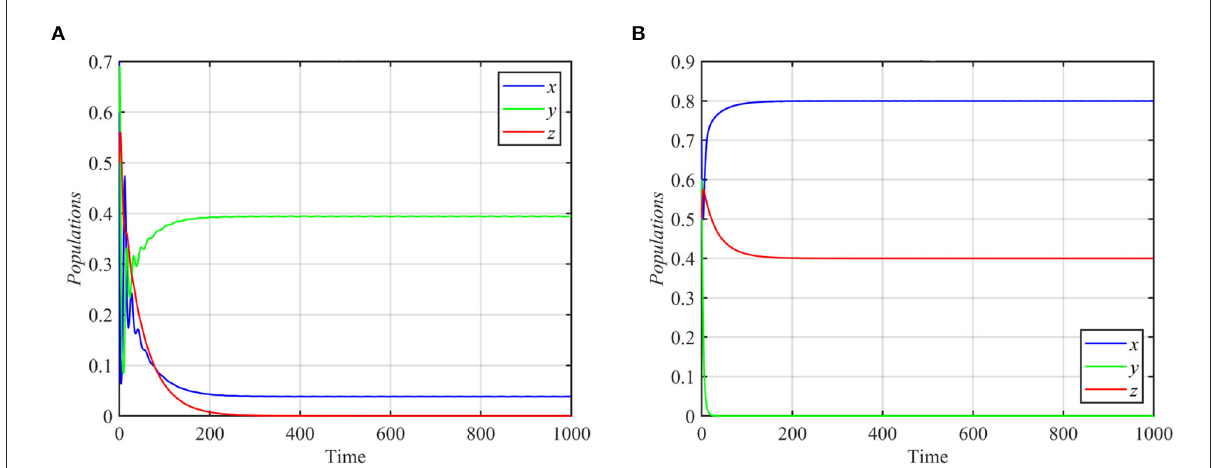
FIGURE4 Trajectories of system (1) for different values of a 1 and other parameters as in equation (17). (A) Time series for trajectories of x , y , and z for a 1 1.75, which approach E 3 =